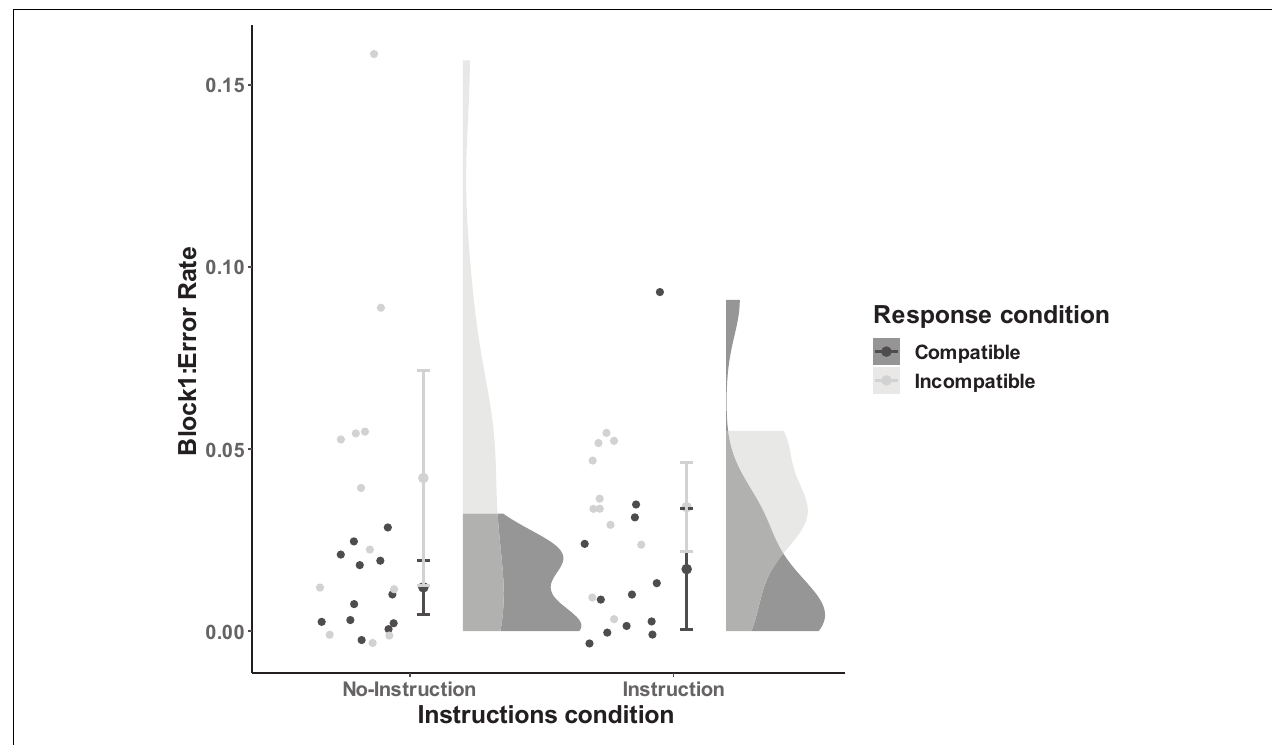
FIGURE 4 | Distribution of error rates as a function of Compatibility and Instructions of block 1 in Experiment 2. The compatible and incompatible trials are defined depending on the Response-Outcome mapping in the acquisition phase. Error bar represent the 95% confidence